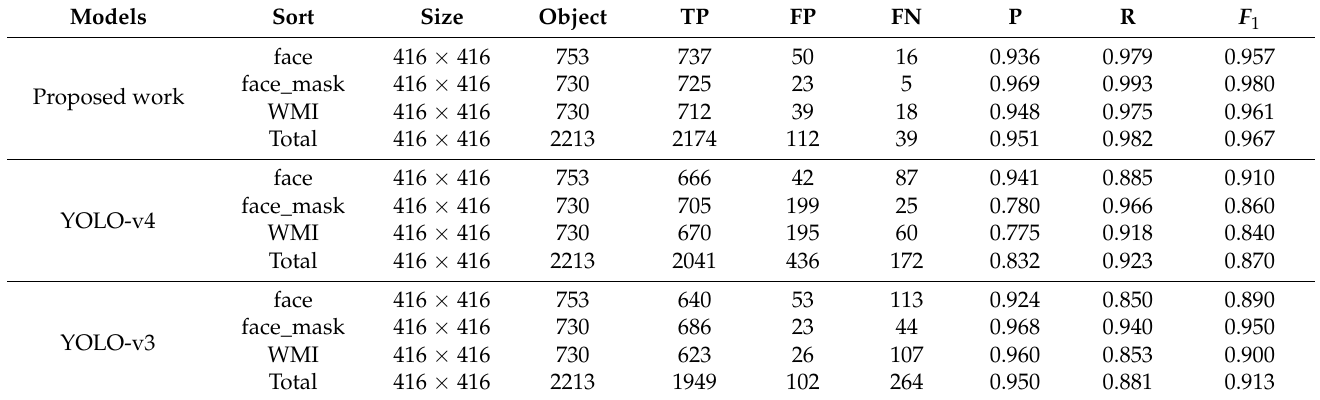
Table 8. Sample detection results of different models on the test set.